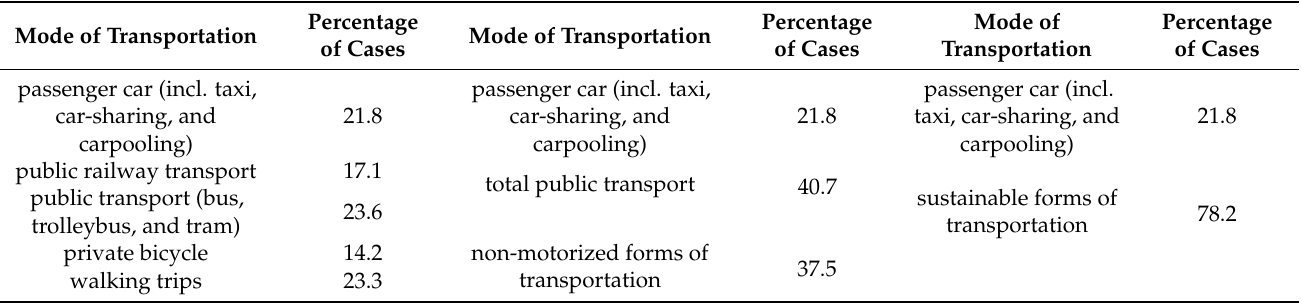
Table 3. What does the metropolitan bike replace for you most often? Answers are from people who have a private passenger car in the household and a driver’s license ( n =